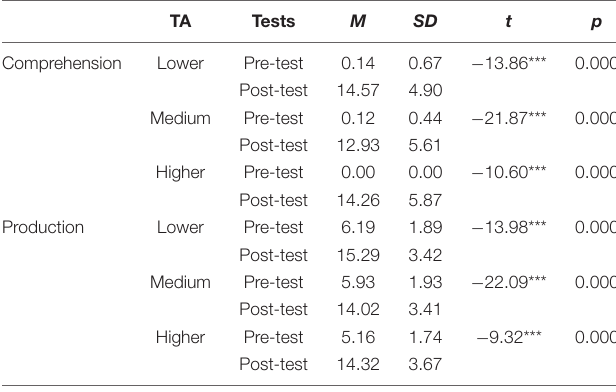
TABLE 2 | Pre–post TS comprehension and production of student translators with different TA.